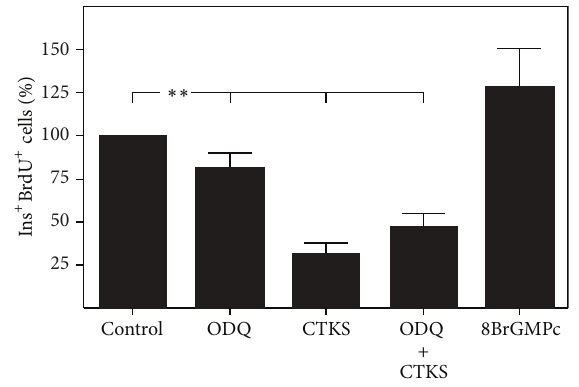
Figure 2: Effect of NO inhibition on islet 𝛽 -cell proliferation. Rat islets were cultured for 48 h in the presence of cytokines IL-1 𝛽 (50U/mL) + IFN- 𝛾 (1000U/mL) + TNF- 𝛼 (1000U/mL) (CTKS) alone or in combination with NOS inhibitor L-NMMA and stained with BrdU over the course of the culture period. Results are presented as percentage means ± SEM of combined BrdU/insulin positive cells relative to insulin-positive cells in a minimum of 5 experiments. ∗ 𝑃 < 0.05 treated versus control.